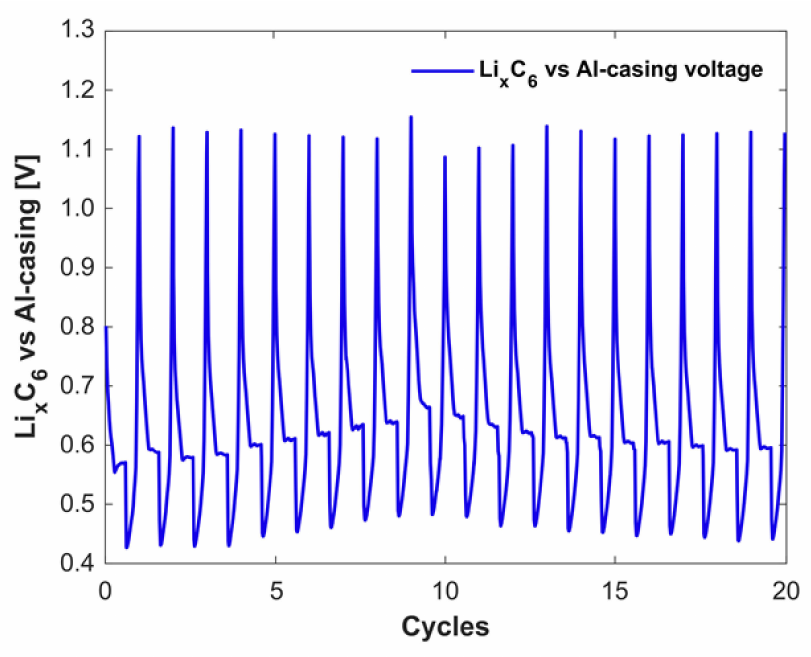
Figure 4. Li x C 6 vs. Al-casing